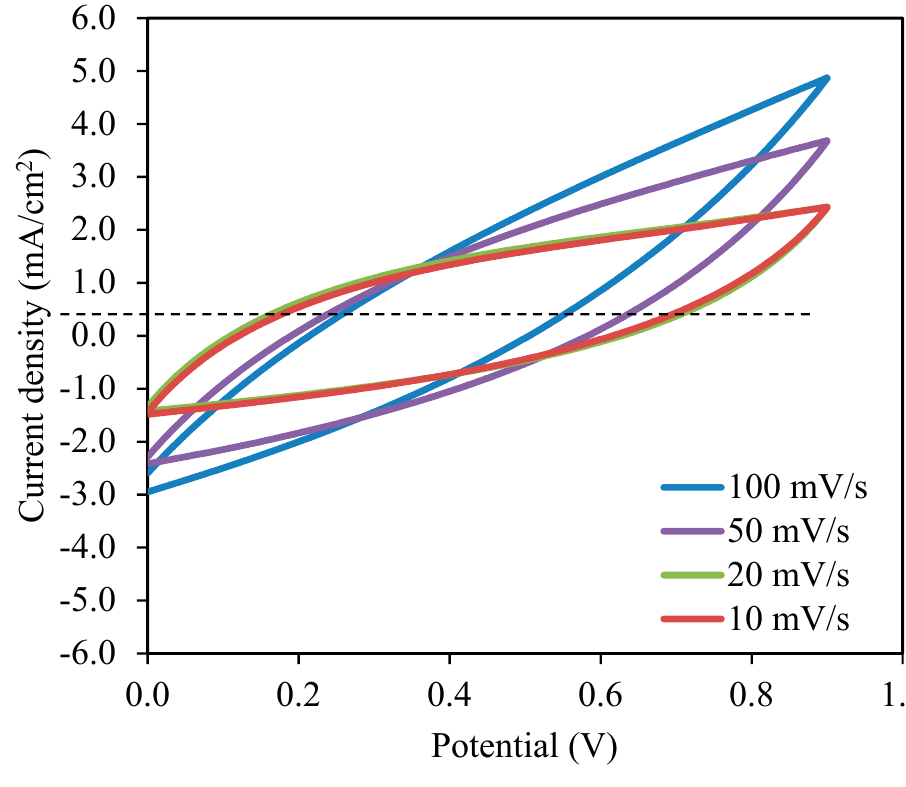
Figure 9. Cyclic voltammetry (CV) curves of the CSMCD3 electrolyte at room temperature.